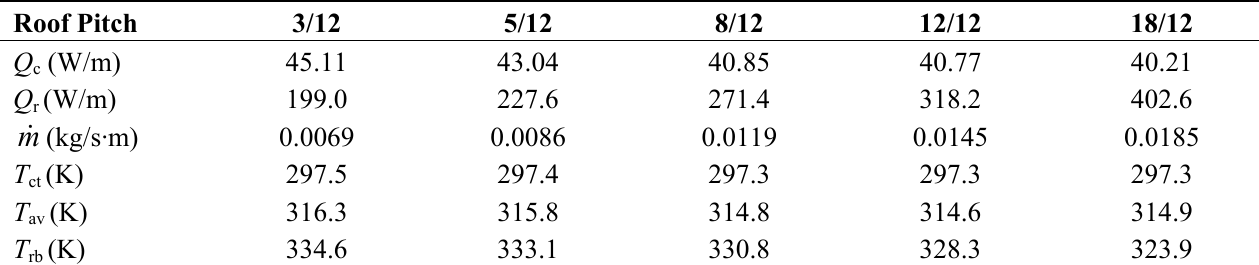
Table 5. Summary of numerical results for R-1.2